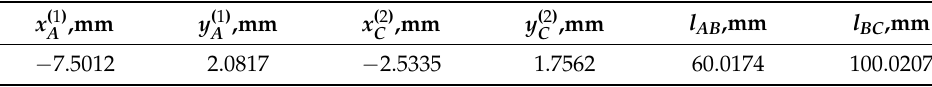
Table 2. Synthesis parameters of the passive CKC ABC.